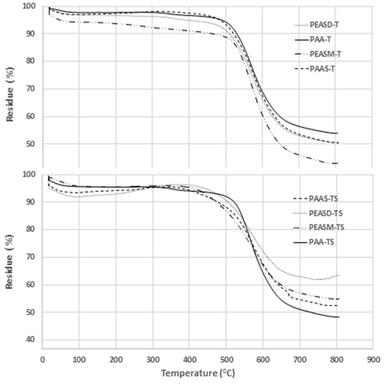
The TGA results.